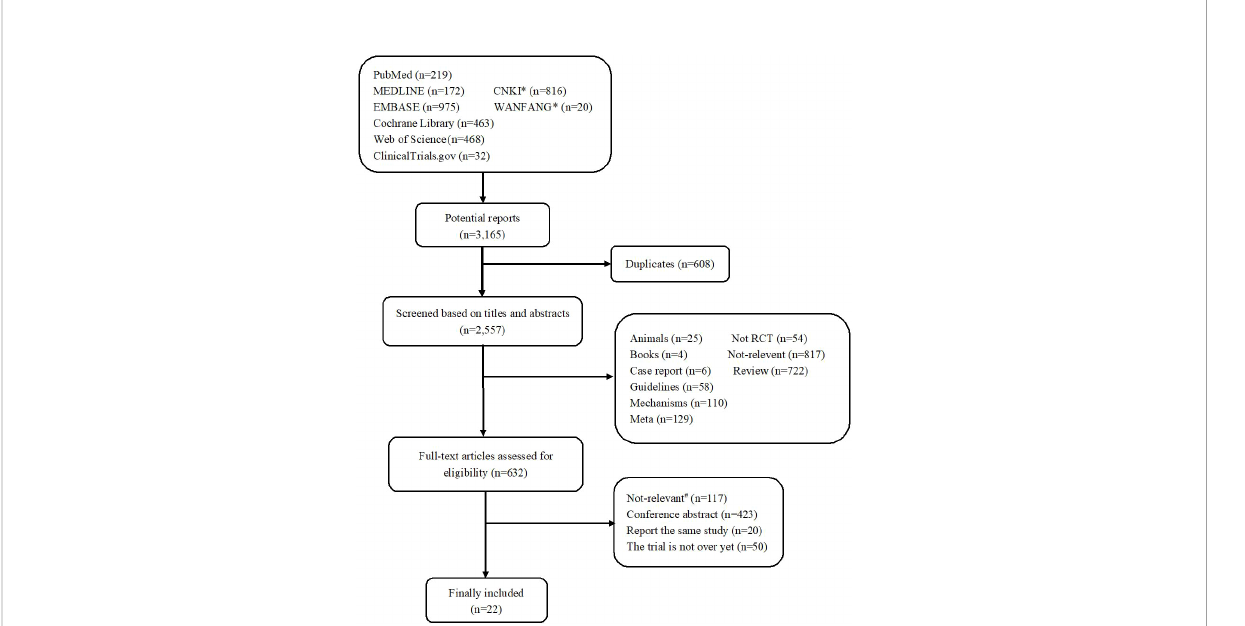
FIGURE 1 Flowchart diagram of the study selection. *CNKI and Wanfang were two Chinese literature databases. # Not-relevant, including non-breast cancer ( n = 6); both the trial group and the control group used pertuzumab ( n = 106); the control group did not use trastuzumab ( n = 2); phase I clinical trial ( n = 2) and without ef fi cacy or safety indicators ( n =